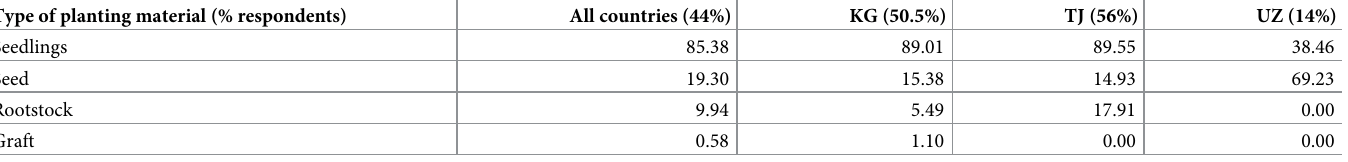
Table 7. Types of planting materials for home gardens sourced from the forest. Type of planting material (%